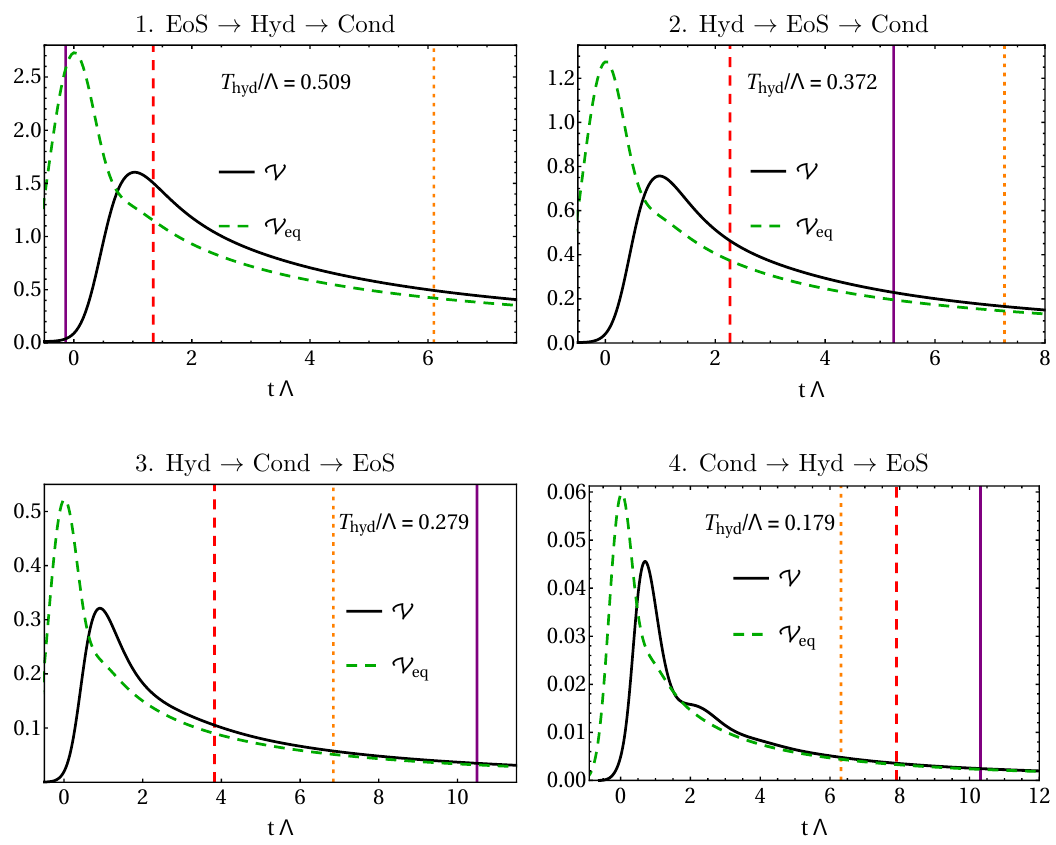
Figure 10 . Comparison between the time evolution of the true scalar condensate V at z = 0 and the equilibrium value V ( E ) that would correspond to the instantaneous energy density, in units eq of (cid:3) 3 , for collisions in the model with (cid:30) = 20 with (cid:22)! = 0 : 30 and (cid:22)= (cid:3) = f 1 : 85 ; 1 : 33 ; 0 : 93 ; 0 : 46 g M from top to bottom and from left to right. The vertical lines indicate the